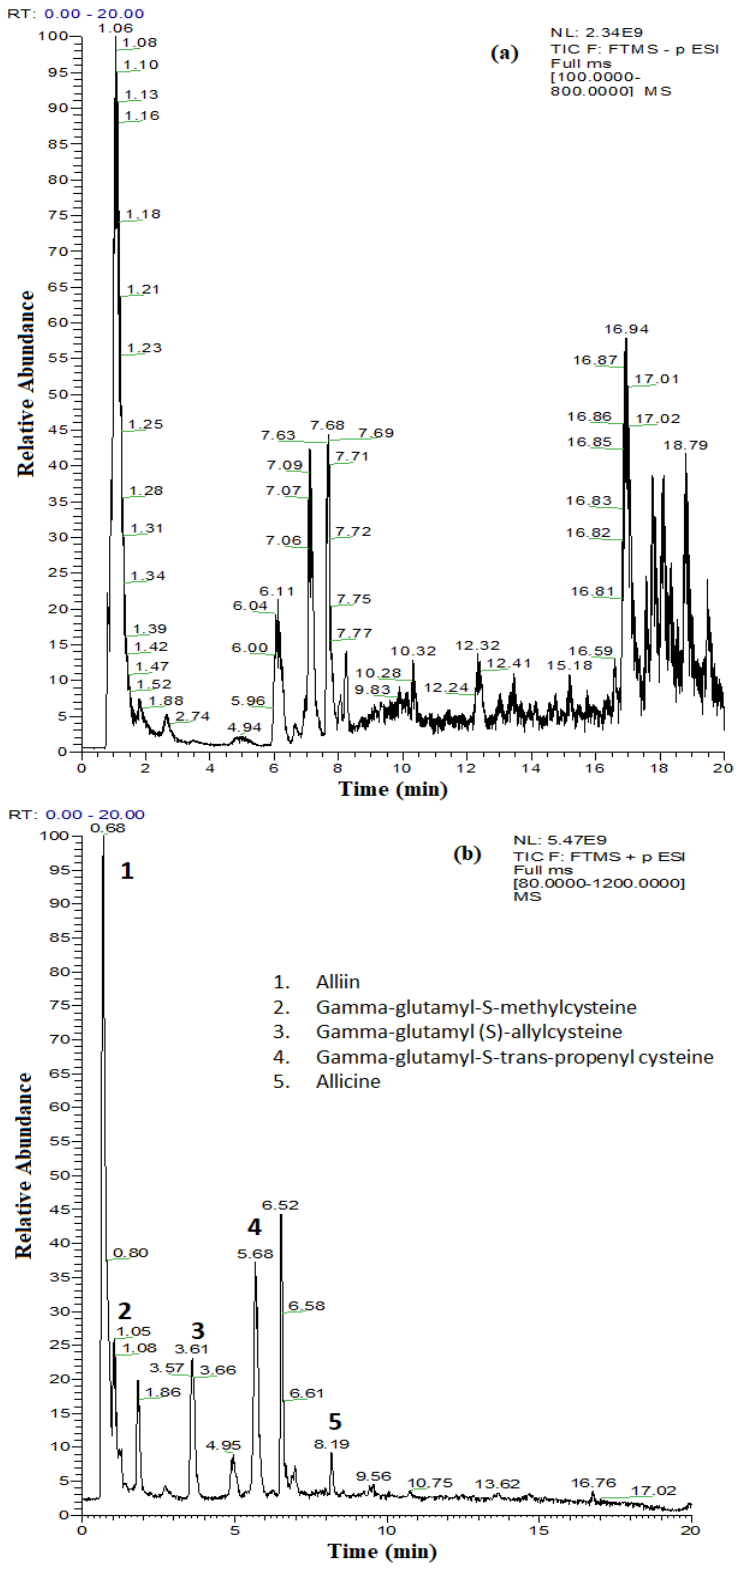
Figure 1. The obtained total ion current (TIC) chromatograms for the separation of ( a ) polyphenolic compounds from A. sativum plant extract by UHPLC–MS/MS detection in negative ionization mode and ( b ) thiosulfinate compounds from A. sativum plant extract by UHPLC–MS/MS detection in positive ionization mode.